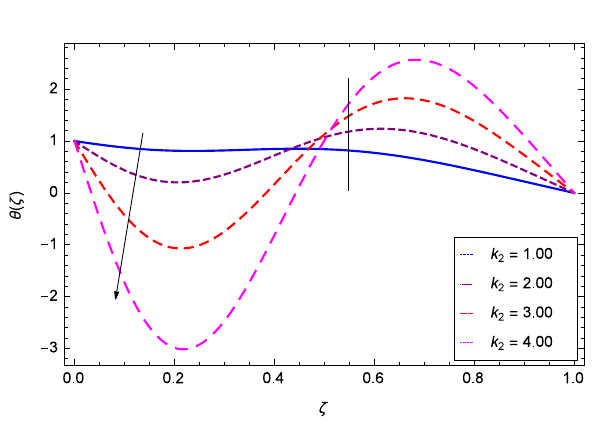
Figure 17. Analysis through stretching parameter k 2 at lower disk and temperature θ ( ζ